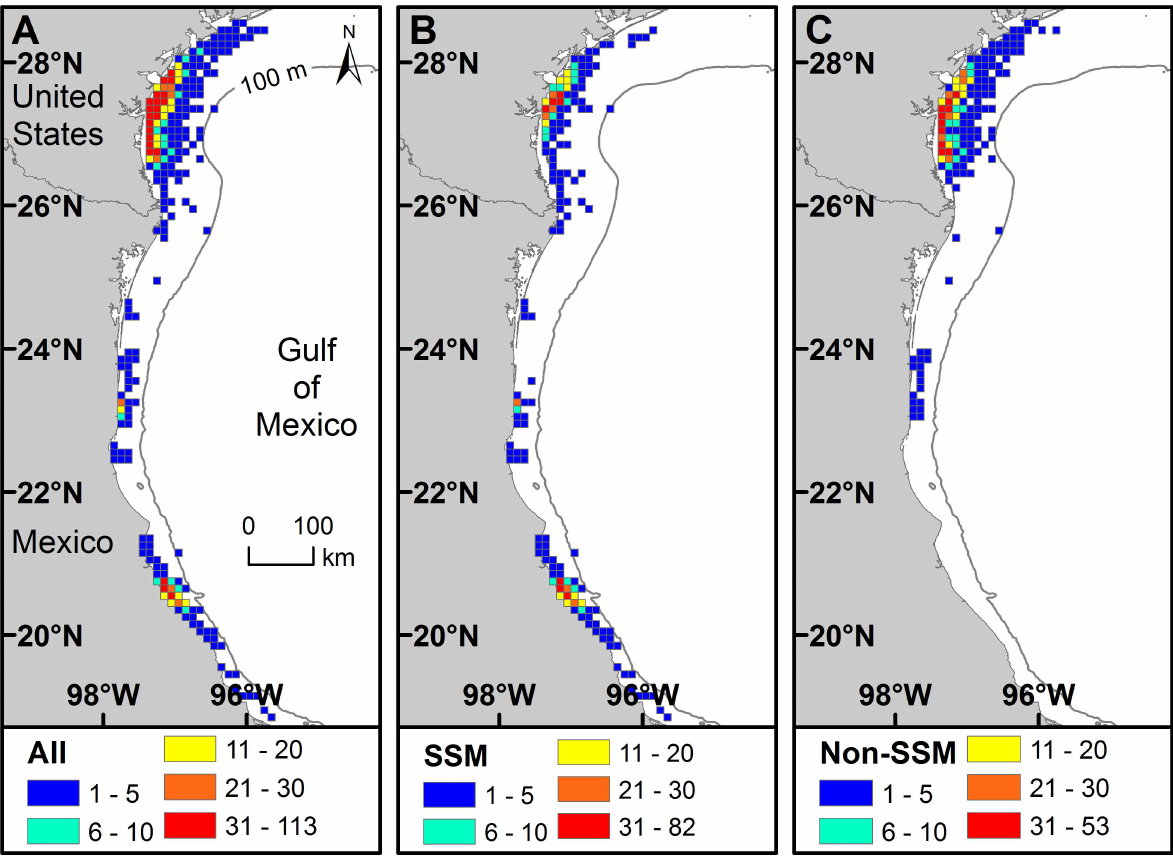
Fig 4. Number of Kemp’s ridley turtle-days spent for (A) all turtles, (B) State-Space Modeled (SSM) turtles, and (C) non-SSM turtles. Each panel includesthe number of days each turtle was observed(turtle-days) in each grid cell using all Argos-retrieved filtered locationsduringthe inter-nestingperiodexcept LC Z.